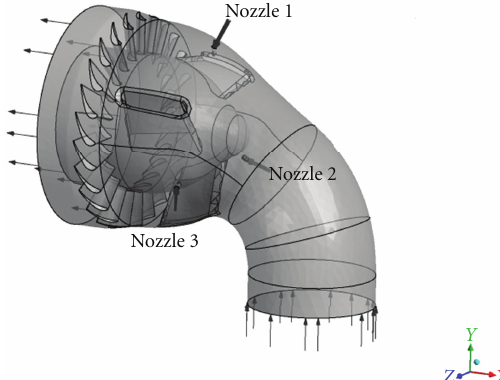
Figure 1: Configuration of a turbocharger with three water washing